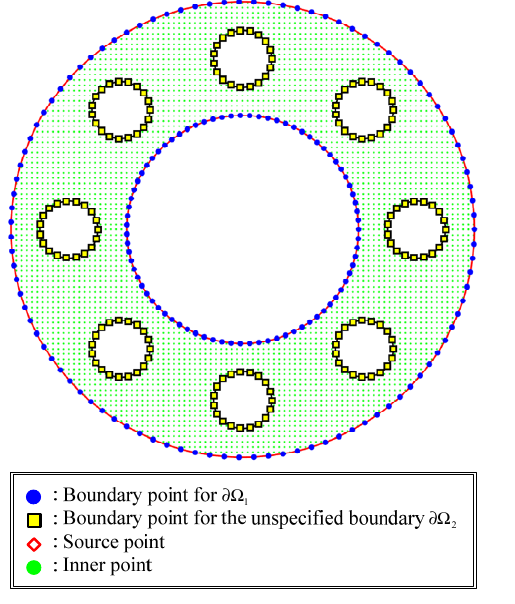
Figure 9. Error versus the dilation parameter.